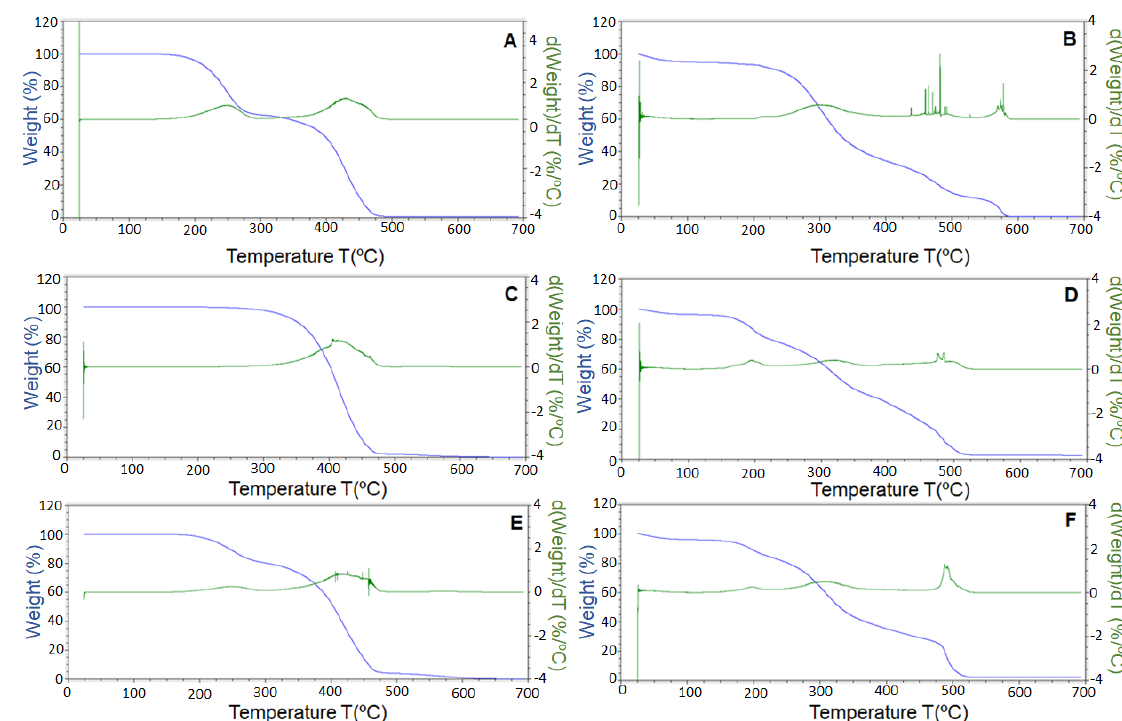
Figure 7. Thermogravimetric analysis curves in the presence of oxygen of ( A ) EPA-rich oil, ( B ) EPA-loaded WPC microparticles, ( C ) docosahexaenoic acid (DHA)-rich oil, ( D ) DHA-loaded WPC microparticles, ( E ) EPA–DHA oils mixture (50:50), ( F ) mixture of EPA-loaded WPC microparticles and DHA-loaded WPC microparticles in mass ratio 50:50.